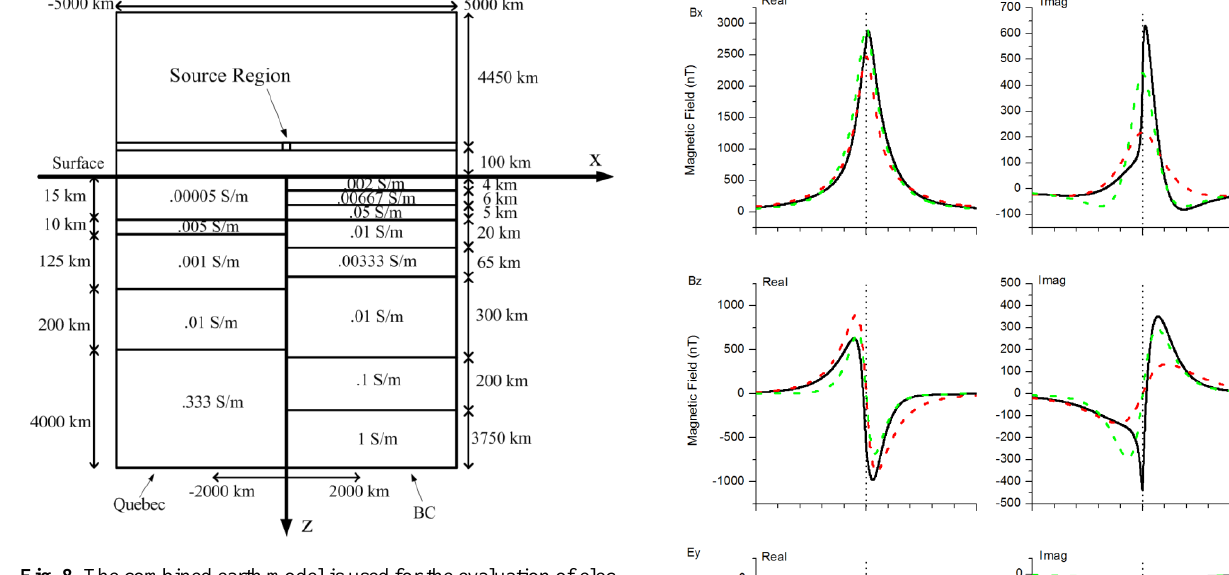
Fig. 8. The combined earth model is used for the evaluation of elec- tric and magnetic fields. For x <0 the Quebec layered earth model is used. For x >0 the British Columbia layered earth model is used. Figure 8. The combined earth model is used for the evaluation of electric and magnetic fields. 2 The conductivities and thicknesses of the different layers are shown. A current is placed at 100km above the surface in a thin 1km layer. For x < 0 the Quebec layered earth model is used. For x > 0 the British Columbia layered 3 earth model is used. The conductivities and thicknesses of the different layers are shown. A 4 current is placed at 100 km above the surface in a thin 1-km layer. 5